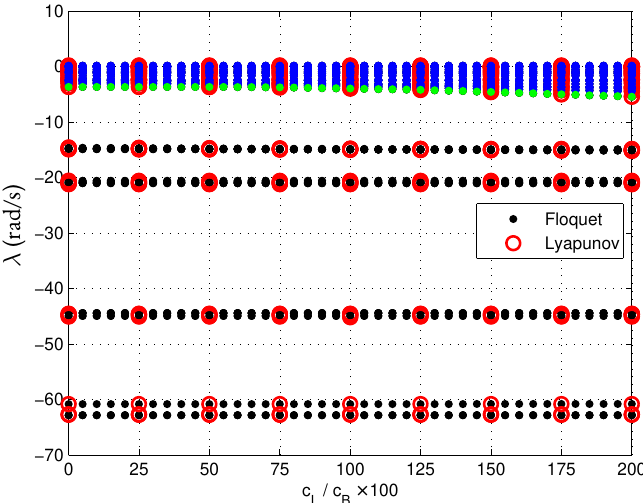
Figure 3. Characteristic exponents estimated by Lyapunov theory (LCEs) and Floquet multipliers, whole range. The lightly damped modes are marked with blue.